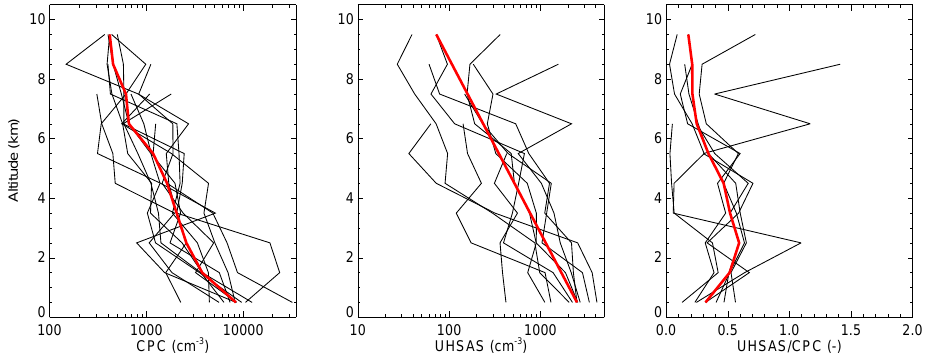
Figure 5. The median of airborne CPC and UHSAS aerosol number concentrations within 1km deep layers for each MC3E flight, and the ratio of those median values for the seven flights with both instruments (black lines). The campaign-wide median profiles (red lines) are archived as Supplement 2.